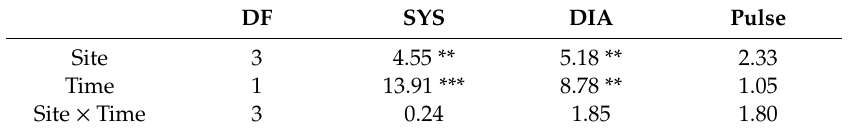
Table 1. Results of mixed-model ANOVA for physiological variables, degrees of freedom and F